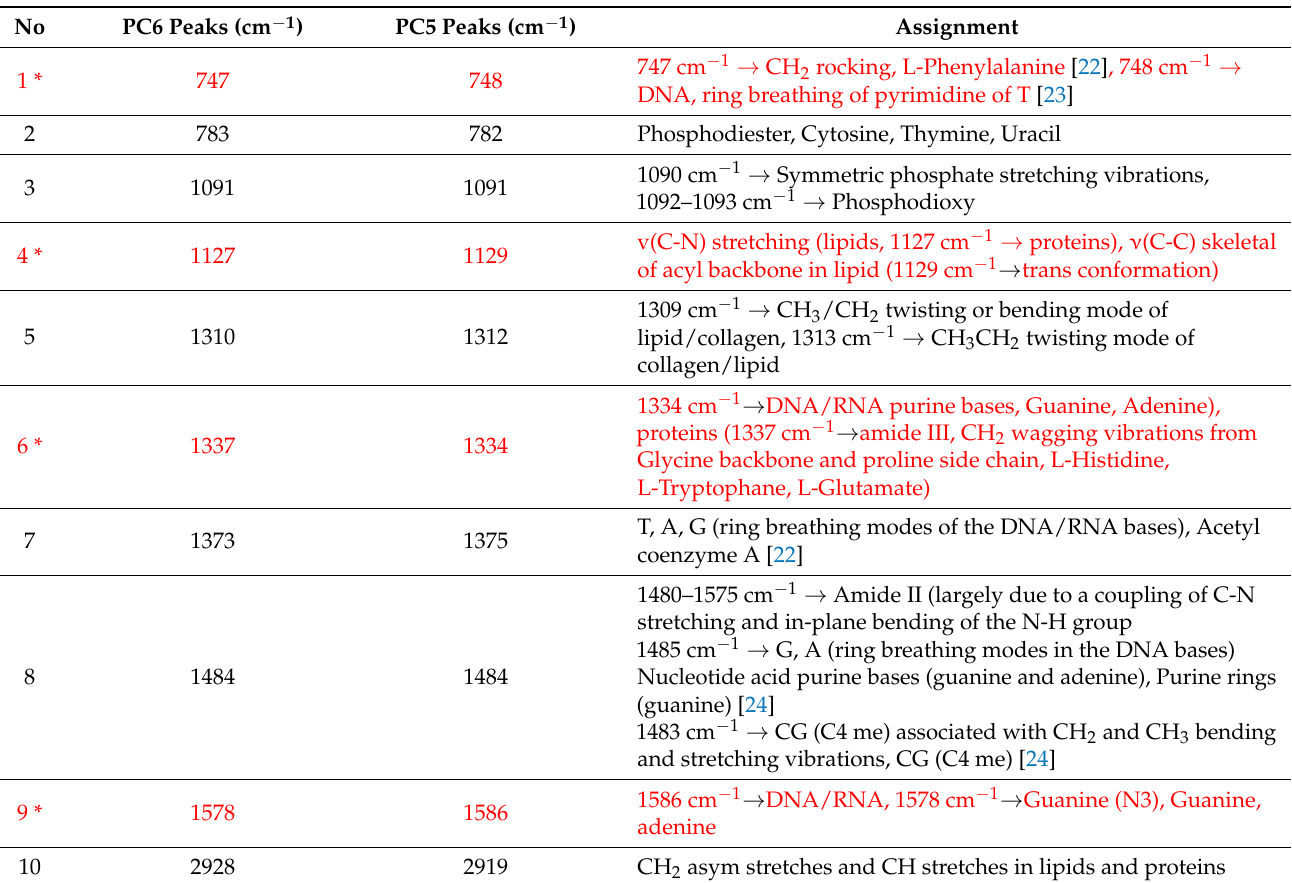
Table 1. Most important Raman signaling differences between HL/cHL and MCL/NHL lymphoma cell lines, with the central wavelength of the Raman peaks and the related assignments. Red color and asterisk superscript correspond to the temperature-dependent Raman